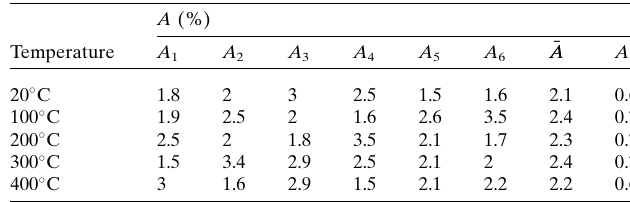
Table 3 Elongation of TIG joints.